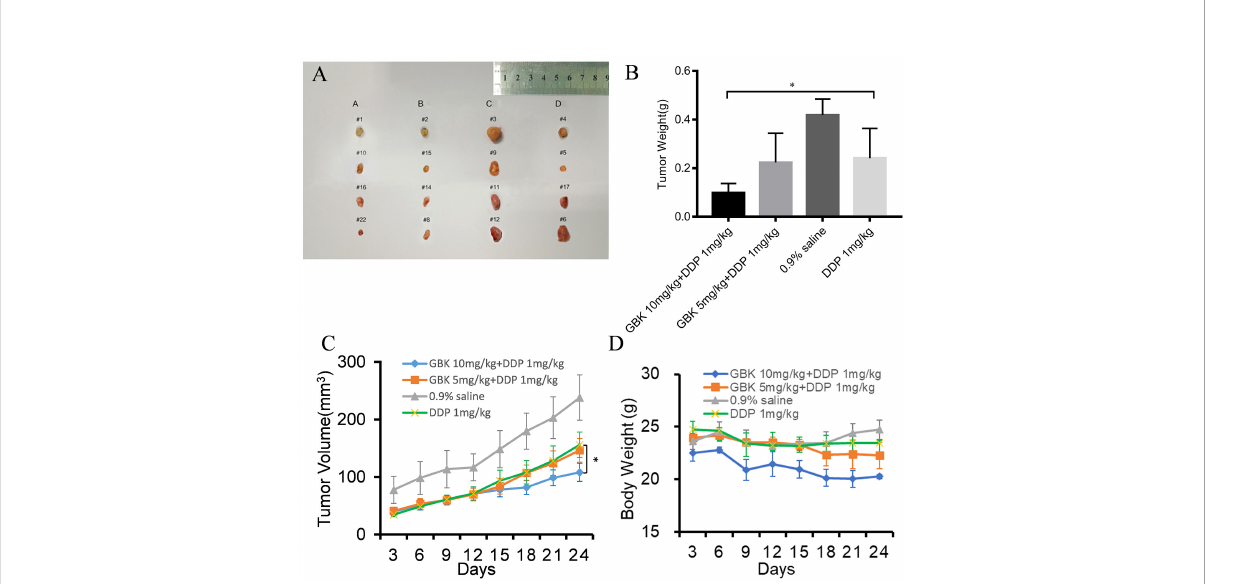
FIGURE 8 The anti-tumor effect of combination treatment with GBK and DDP on breast cancer. (A) SUM-159 cells were injected into the fl anks of NOD/ SCID mice, and when the tumors had grown to ~5 – 6 mm in diameter, the following treatment regiments were administered intraperitoneally as described for 24 days: GBK 10 mg/(kg.1D) and DDP 1 mg/(kg.2Ds) in group A, GBK 5 mg/(kg.1D) and DDP 1 mg/(kg.2Ds) in group B, 0.9% saline in group C, and DDP 1 mg/(kg.2Ds) in group D. (B) On day 24, tumors were excised and subjected to weight analysis. (C) On day 0, the tumor size was normalized to 1 for all the groups. Tumor volume was monitored and measured every 3 days. (D) Body weights of the NOD/SCID mice in groups A, B, C, and D were monitored for 24 days. Data are presented as mean ± s.e.m. of four independent mice. Student ’ s t test, *p <